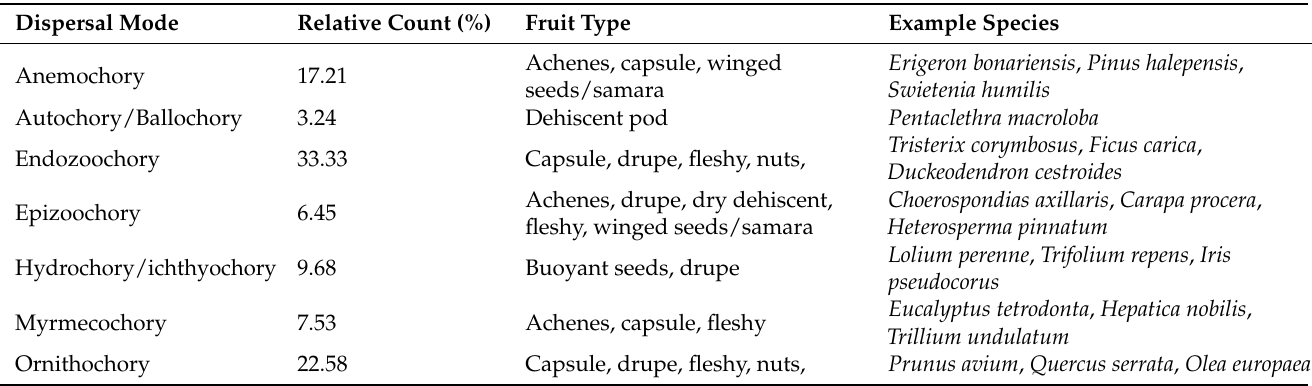
Table 1. The identified most frequently studied dispersal strategies by fruit type in the reviewed studies.